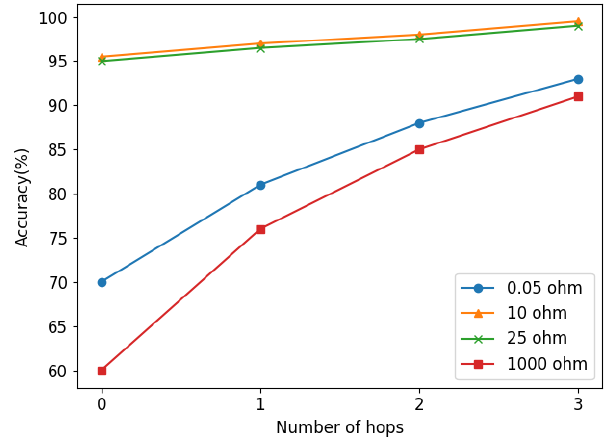
Figure 9. Fault location results with different fault resistance. Table 2. Comparison results with different fault resistance. Fault Re- MAPE of Feature Recon- Accuracy of Fault Clas- Accuracy of Fault sistance figuration sification Location 0.05 Ω